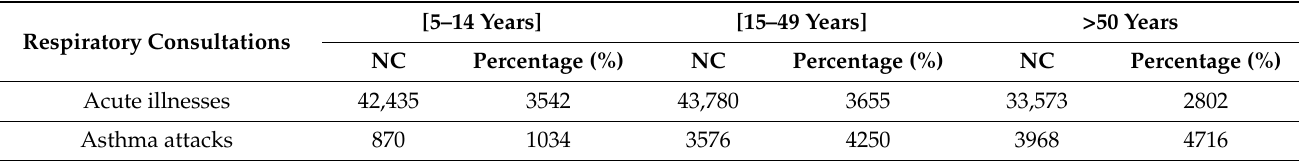
Table 3. Reasons for consultation in subjects aged five years and older by age